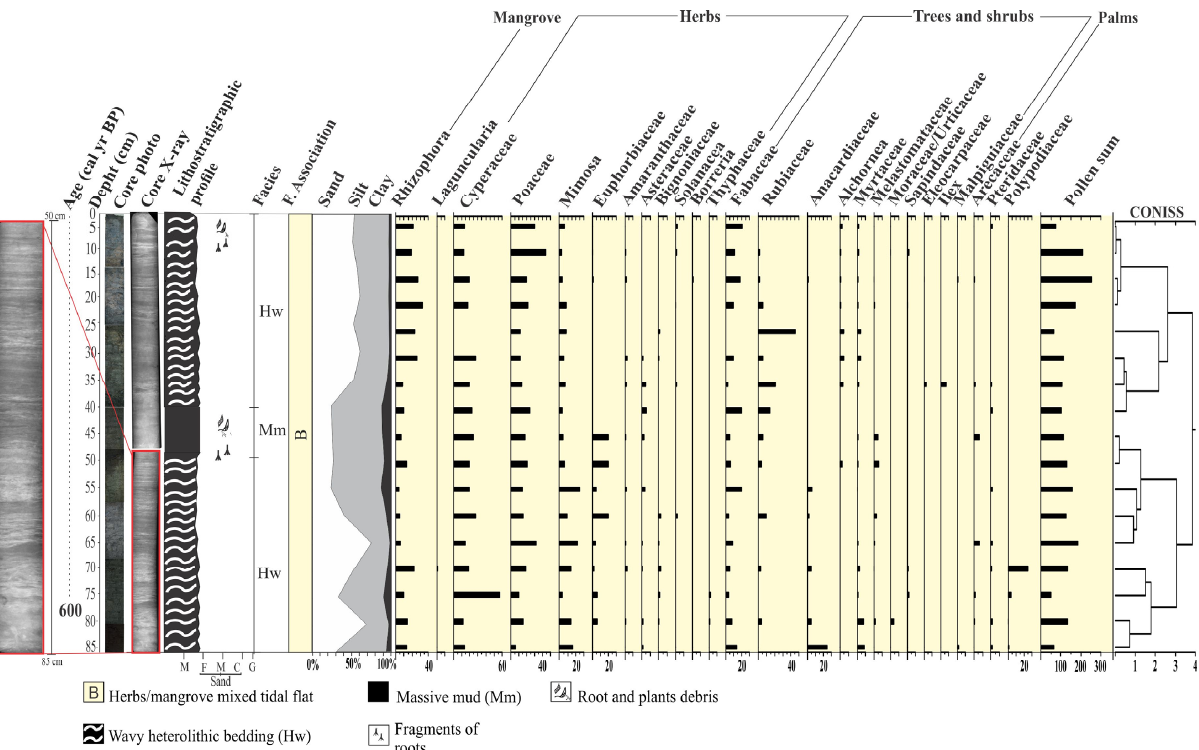
Figure 6. Pollen diagram of core NAT − 3, with percentages of the most frequent pollen rates, age of the samples, and cluster